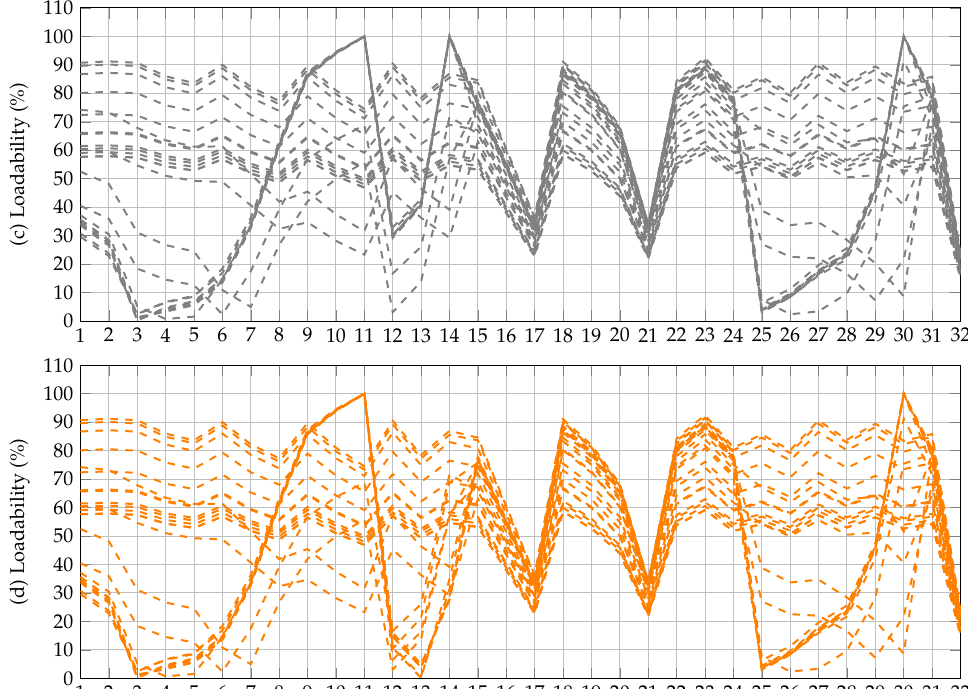
Figure 7. Percentage of variation of the current at each distribution line at each period of analysis: ( a ) current behavior in the benchmark case (no PV plants connected); ( b ) current behavior when E loss is minimized; ( c ) current behavior when E costs is minimized; ( d ) current behavior when E CO